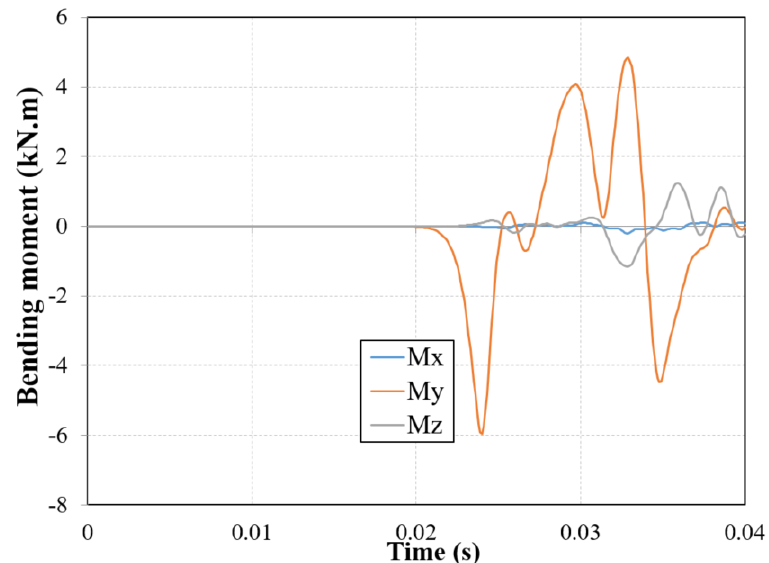
Figure 10. Components of bending moment acting on the obstacle at a distance of 10 m depending on time.